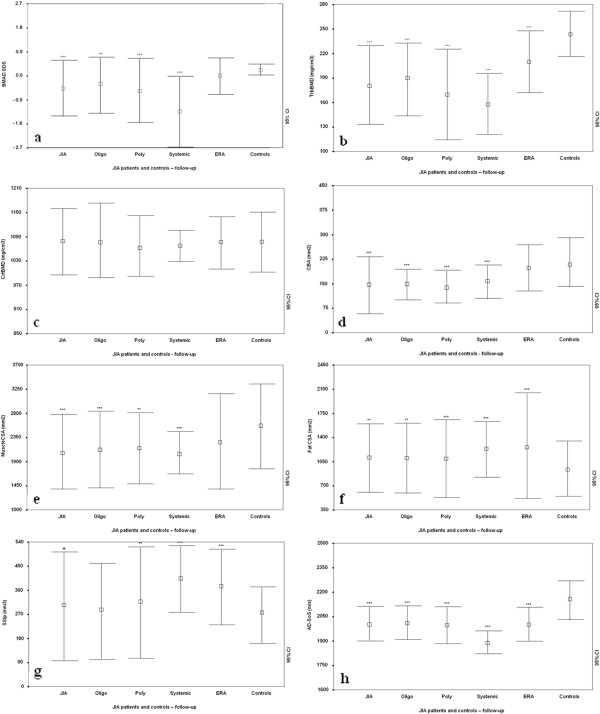
Longitudinal evaluation. Spine bone mineral apparent density (spine BMAD) SDS (a), trabecular bone mineral density (TrabBMD) (b), cortical bone mineral density (CrtBMD) (c), cortical bone area (CBA) (d), muscle cross-sectional area (MuscleCSA) (e), fat cross-sectional area (FatCSA) (f), density-weighted polar section modulus [SSIp] (g), and Ad-SoS (h) in patients with oligoarticular, polyarticular, systemic, and enthesitis-arthritis (ERA) JIA versus controls. Bars represent means and 95% confidence intervals. **P < 0.005; ***P < 0.001.